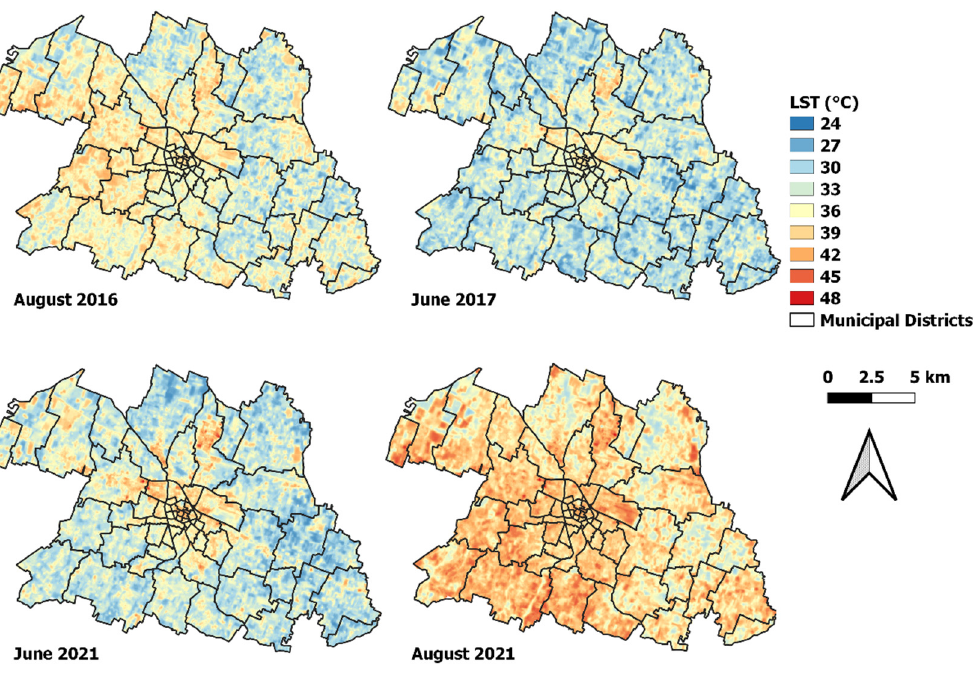
Figure 4. LST maps obtained from Landsat 8 imagery acquired on 27 August 2016 ( upper left ), 2 June 2017 ( upper right ), 13 June 2021 ( lower left ), and 9 August 2021 ( lower right ), framed on the municipal districts of Reggio Emilia.